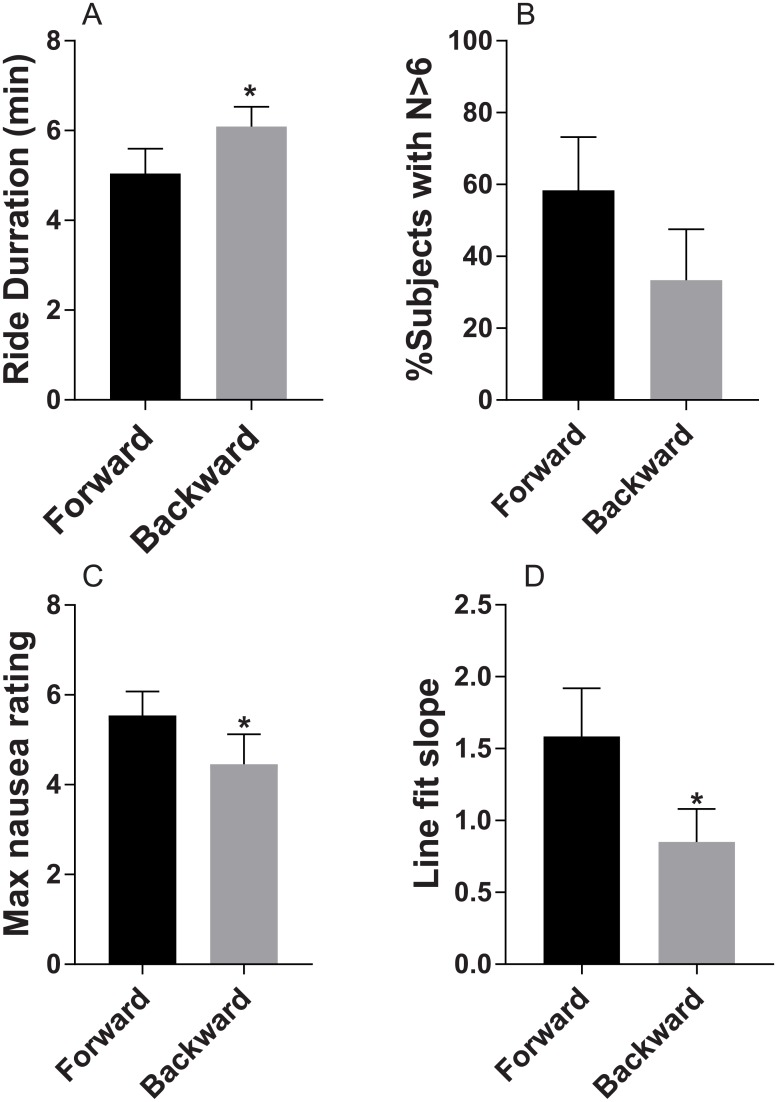
Reversing direction of virtual ride prolongs ride tolerance time and reduces real-time nausea scores.A—Average ride duration in forward and backward rides. B—Number of subjects reporting high level of nausea. C—Maximum nausea reported during the ride. D—Average slope of linear regression for individual’s nausea rating vs. time. *—P<0.05.